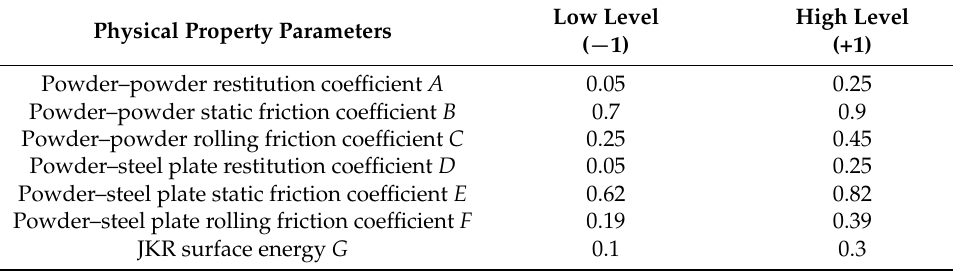
Figure 4. The angle of repose test: ( a ) FT-104B resting angle tester; ( b ) resting angle simulation model. Table 5. Range of simulation test parameters.